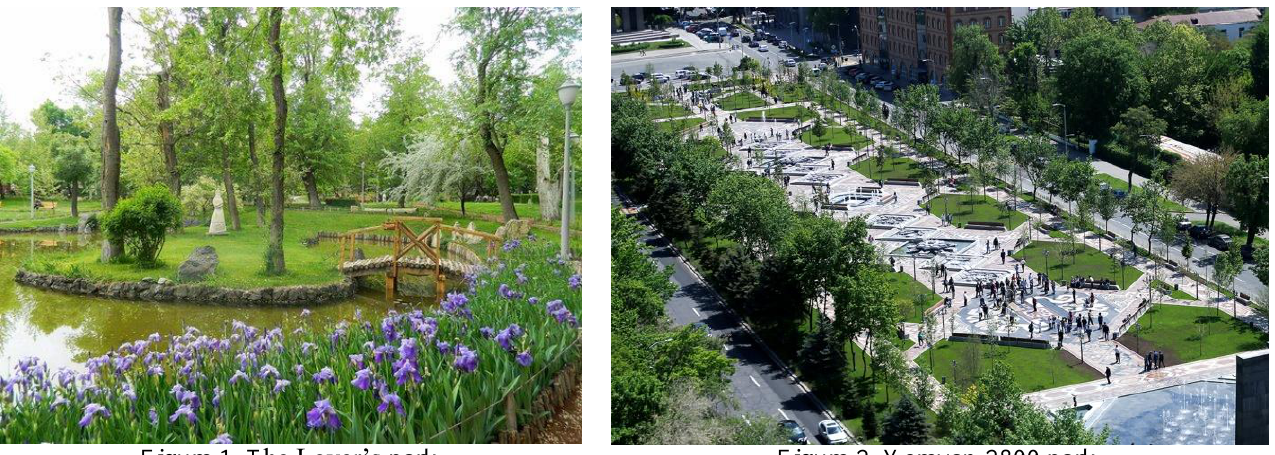
Figure 1. The Lover’s park Figure 2. Yerevan-2800 park